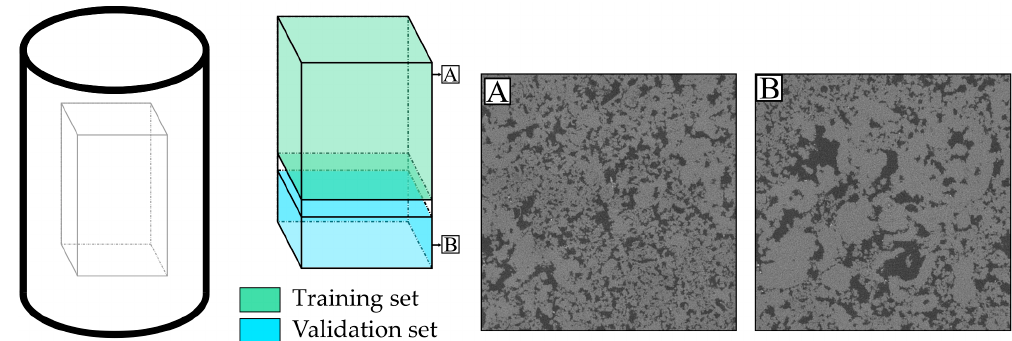
Figure 3. Dataset preparation. The same prism is extracted from each input volume, which are four scans at resolutions 4, 8, 12 and 16µm, respectively. Then, from the 4 and 12 µm scans, training and validation data was extracted for training of the super-resolution C-GAN. Training and validation data are non-overlapping and not adjacent to ensure sufficient variability between the pore network, as to avoid overfitting of the neural networks. A and B show that pore structures can significantly change within one sample. A . has smaller, regularly distributed pores, at the top of the sample and B has more pore size variation in the lower part of the sample.